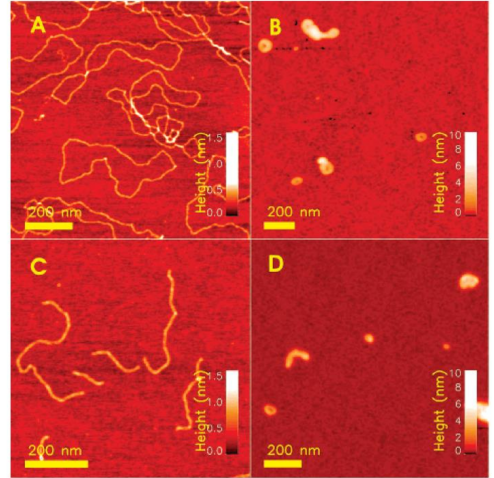
Figure 6. Tapping mode AFM height topographs of: uncomplexed pBR322 ( A ); and linear DNA ( C ); alongside with complexes of these formed when mixed with the chitosan C (0.01,162) ( B , D ) cDNA 4 µ g/mL and N/P = 1. Reprinted with permission from Danielsen et al. (2004) Biomacromolecules